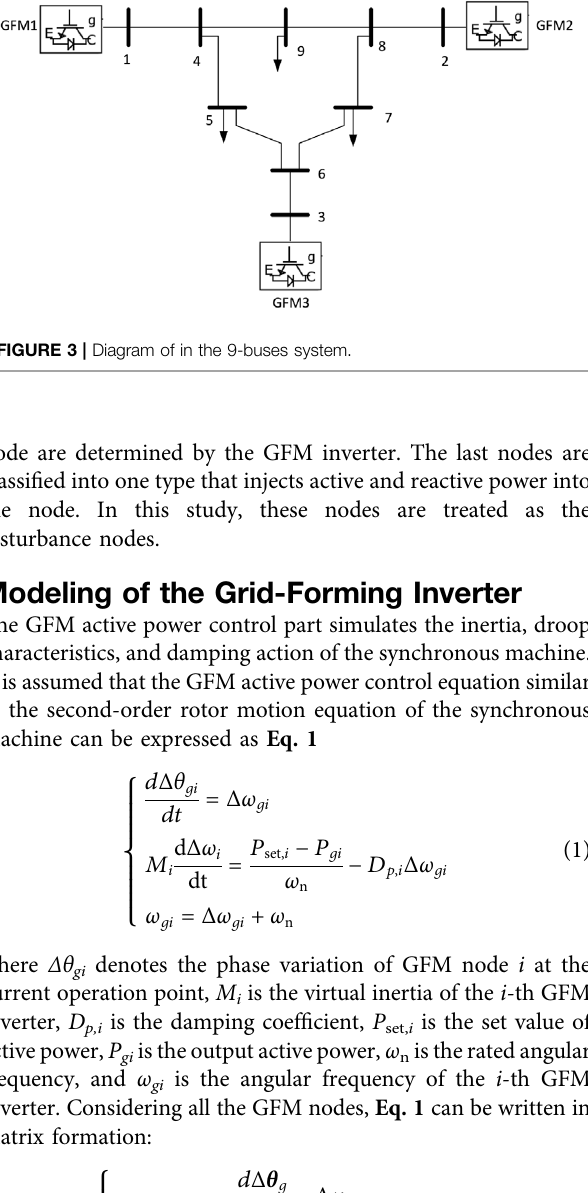
TABLE 1 | | Parameters of the system and the inverters. Base values